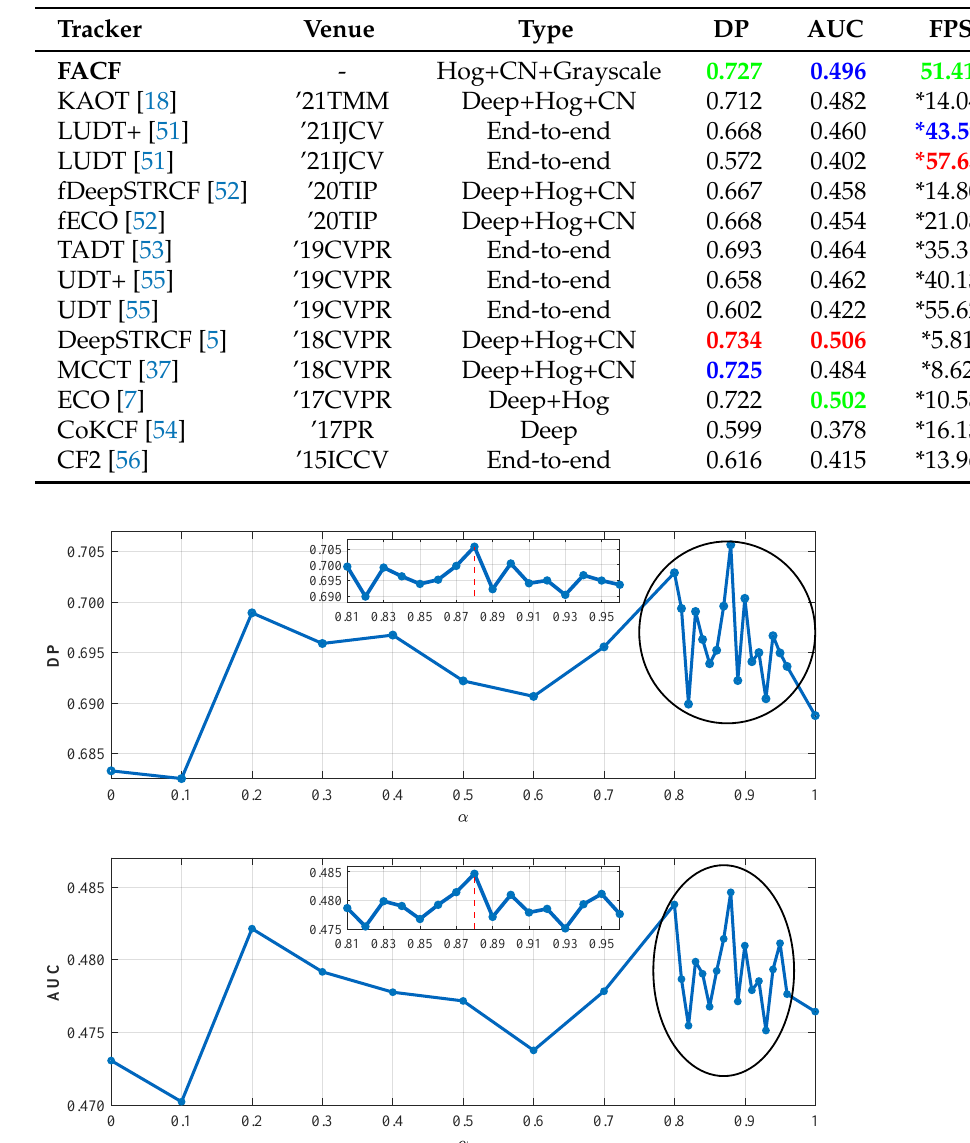
Table 3. Performance comparision of the proposed tracker and 13 other deep-based trackers on DTB70 [25] benchmark. Red , green , and blue represent the top three trackers in terms of DP, AUC and FPS, respectively. The superscript ∗ means GPU spped.